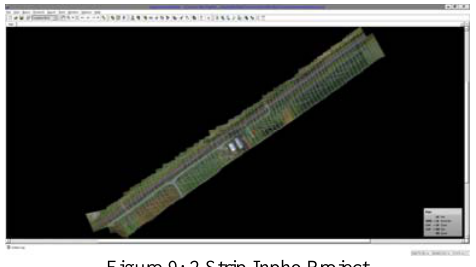
Figure 9: 2 Strip Inpho Project